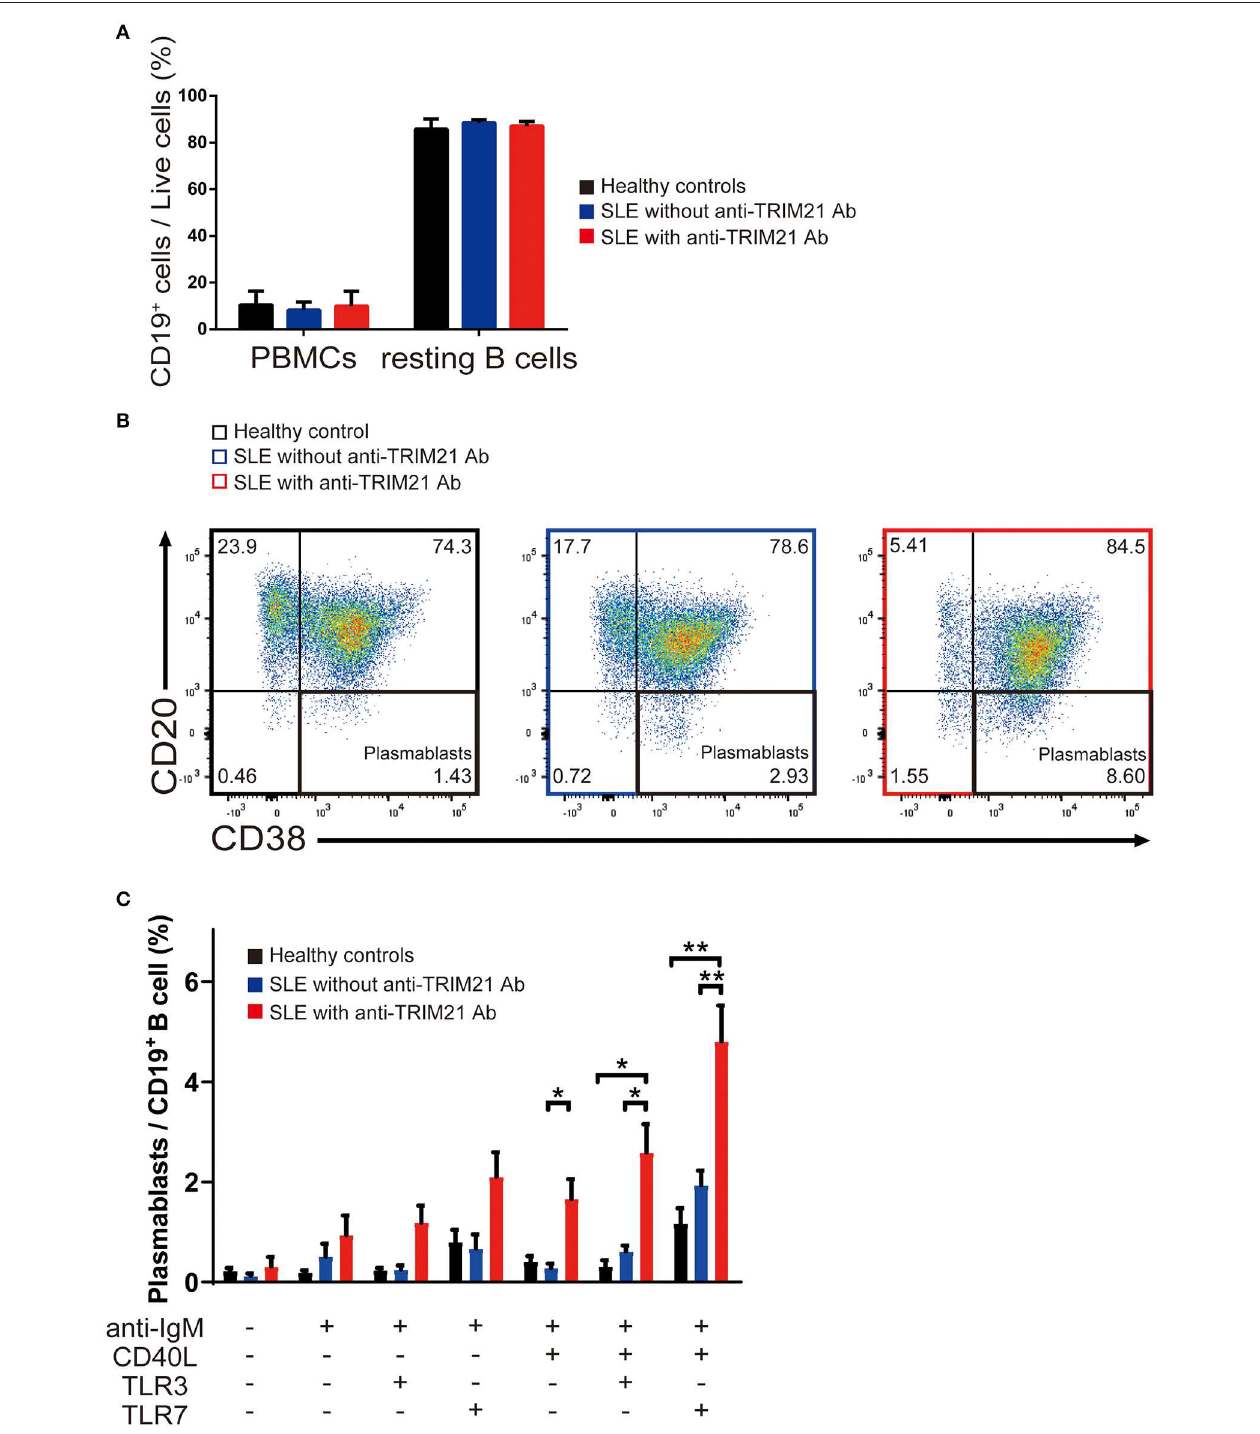
FIGURE 10 | The seropositivity of anti-TRIM21 Ab is related to aberrant B cell differentiation in patients with SLE. (A) Percentages of CD19 + B cells in PBMCs and in resting B cells isolated by magnetic-activated cell sorting in SLE patients with anti-TRIM21 Ab, those without anti-TRIM21 Ab and healthy controls. (B) Flow cytometric analysis shows an increased rate of CD19 + CD20 − CD38 + plasmablasts at 24h after stimulation with anti-IgM Ab, CD40L, and TLR7 ligand. The panels show the cells after gating with population positive to both CD19 and CD27. (C) Percentage of plasmablasts at 24h after stimulation with anti-IgM Ab, CD40L, and/or TLR3/7 ligands in healthy controls ( n = 5), SLE patients without anti-TRIM21 Ab seropositivity ( n = 11) and those with anti-TRIM21 Ab seropositivity ( n = 6). Values are shown as means ± SEM. Statistically significance data (* p < 0.05 and ** p < 0.01) by Student’s t -test, respectively.